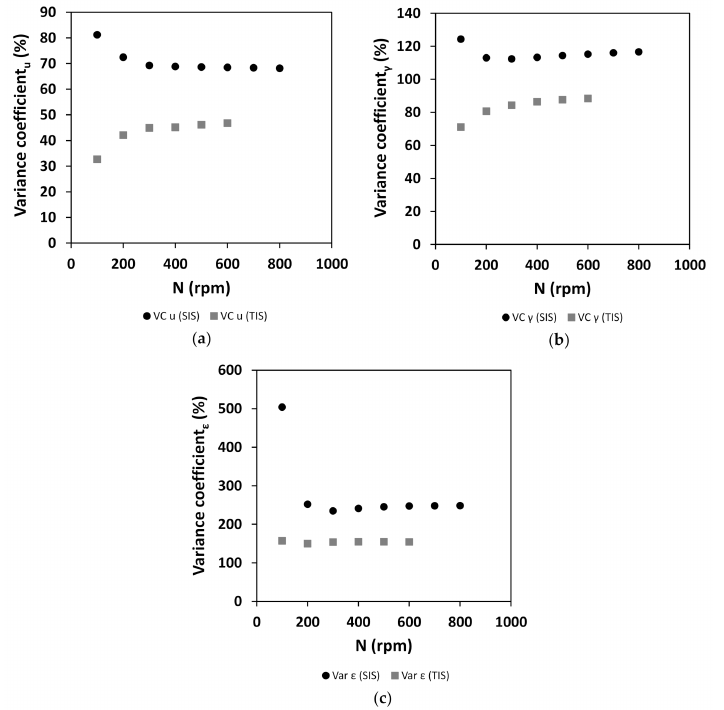
Figure 10. Variance coefficients for hydrodynamic parameters: ( a ) fluid velocity u, ( b ) shear rate γ , and ( c ) energy dissipation rate ε in both cultivation systems. The coefficients were calculated from standard deviations from slice plot data divided by their mean value. They represent a measure of hydrodynamic homogeneity of the respective reactor